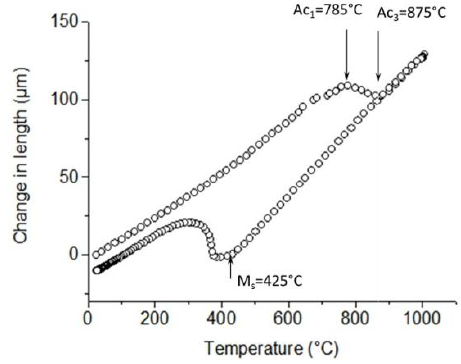
Figure 6. Change in length versus temperature obtained by dilatometry for material heated at 150 °C/s to 1000 °C and quenched. The formation of austenite during heating was complete.